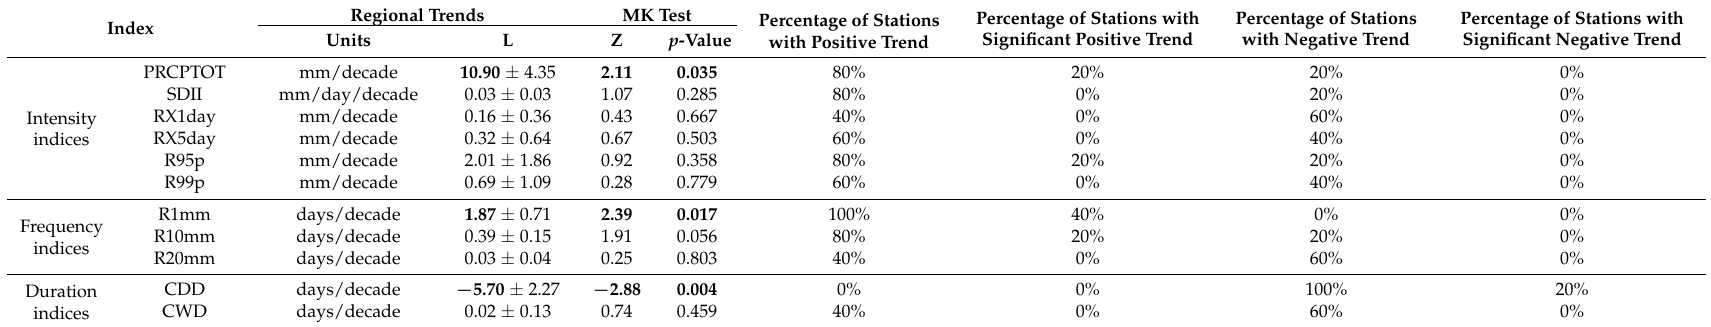
Table 3. Regional trends per decade, the results of the Mann–Kendall (MK) test and percentages of stations with positive and negative trends for the extreme precipitation indices over the SRYR during 1960–2016.